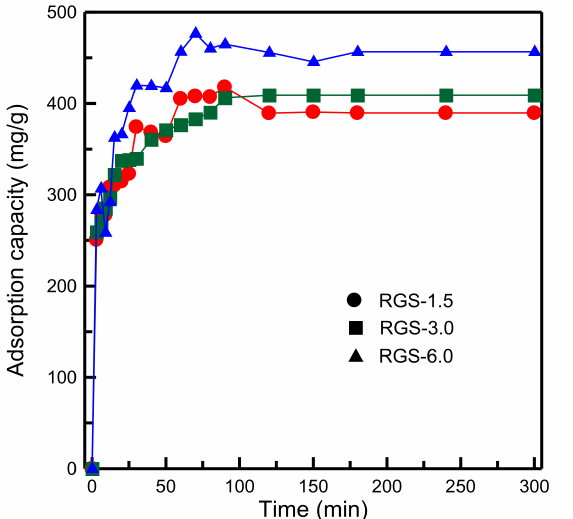
Figure 10. Influence of different amounts of GO suspension on adsorption capacity of RH-